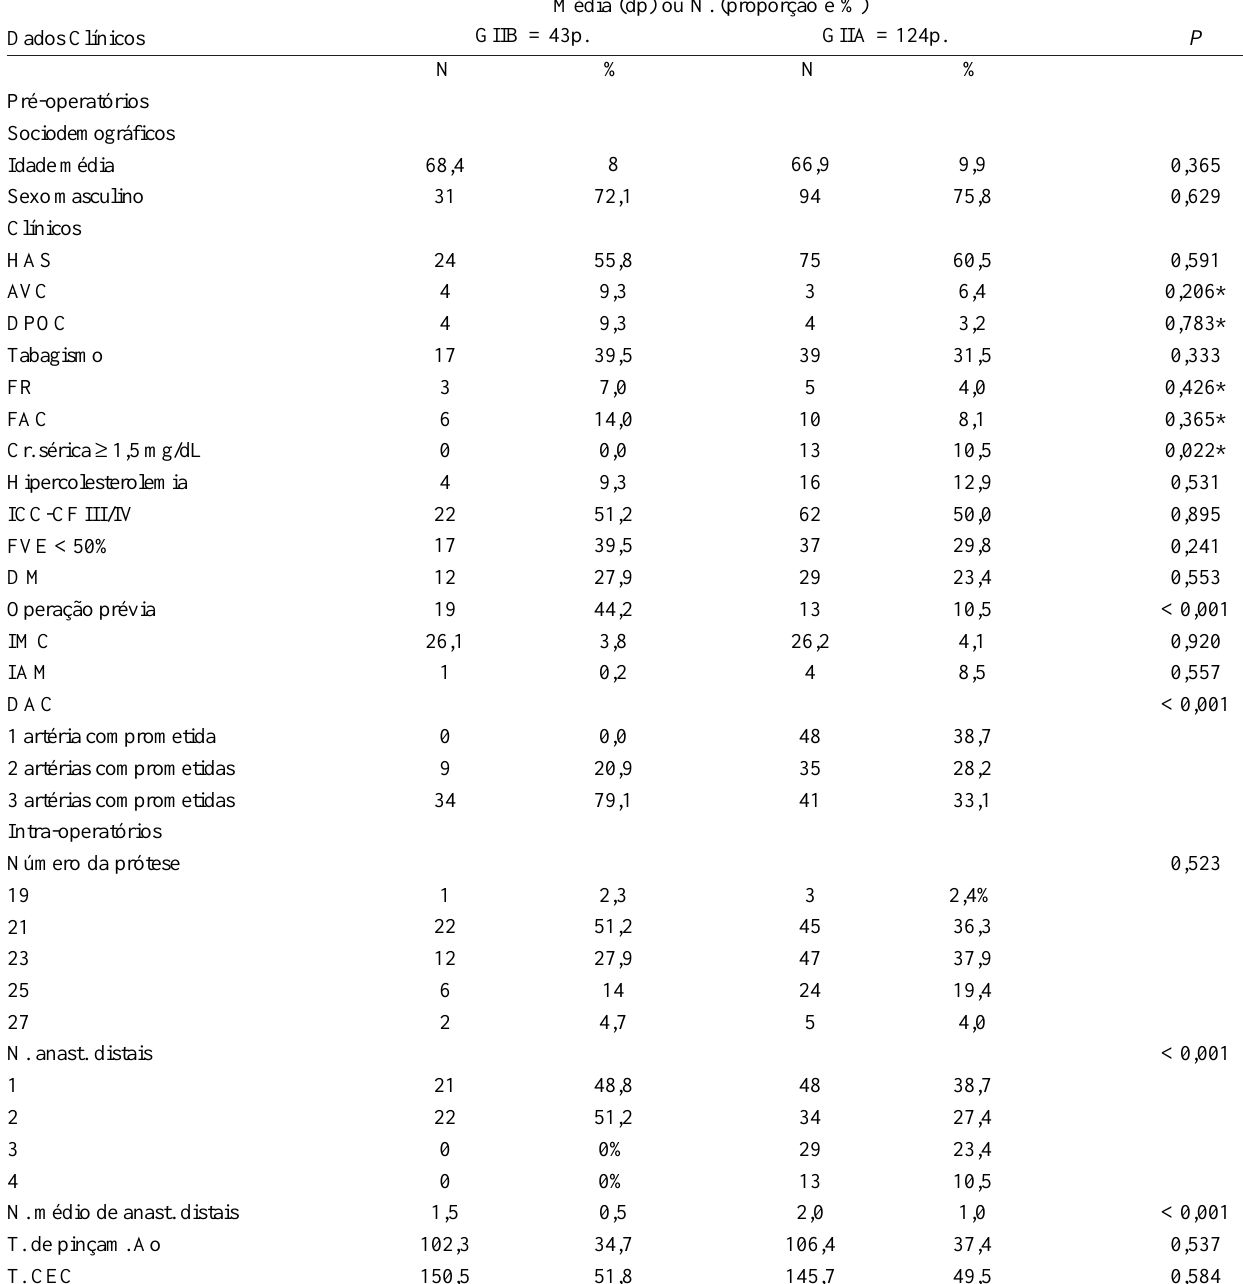
miligrama; dl: decilitro; T. pinçam. Ao.: tempo de pinçamento aórtico em minutos; T. CEC: tempo de circulação extracorpórea em